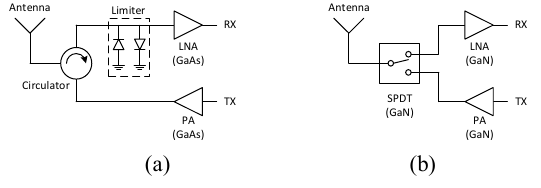
Figure 1: A general transceiver architecture